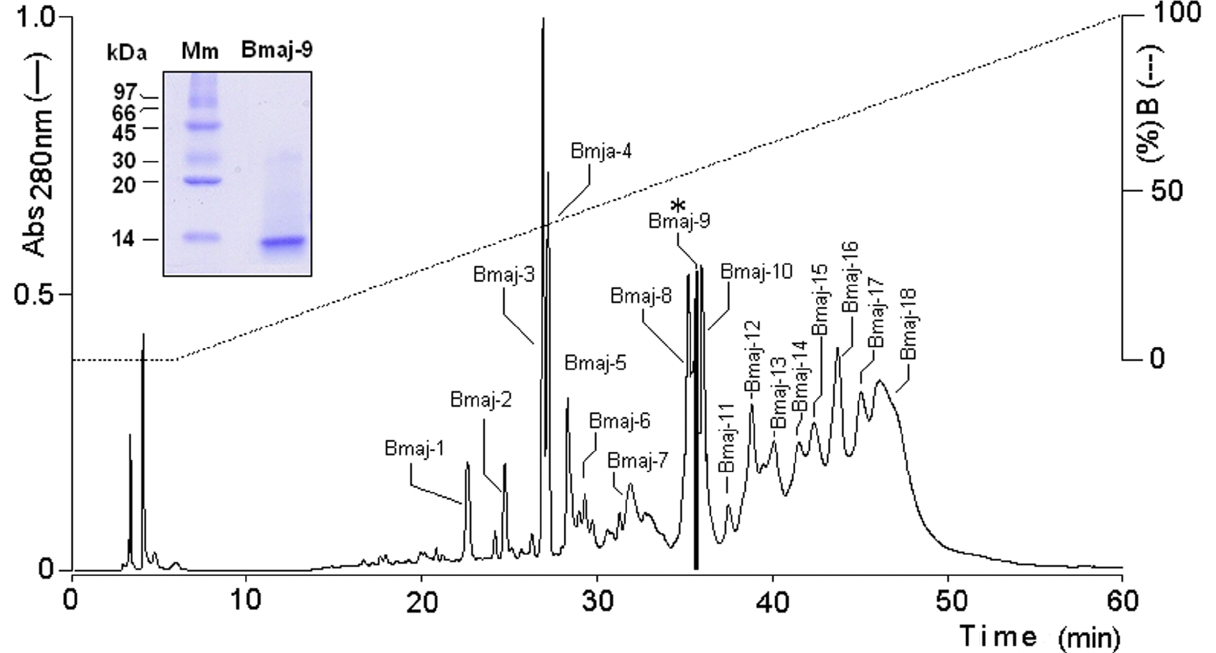
Figure 1. RP-HPLC chromatography of B. marajoensis crude venom. The elution profile (280 nm, 55% solvent B; retention time of 36 minutes) displays Bmaj-9 (*) as the main fraction obtained. Insert: electrophoretic profile in SDS-PAGE (12.5%